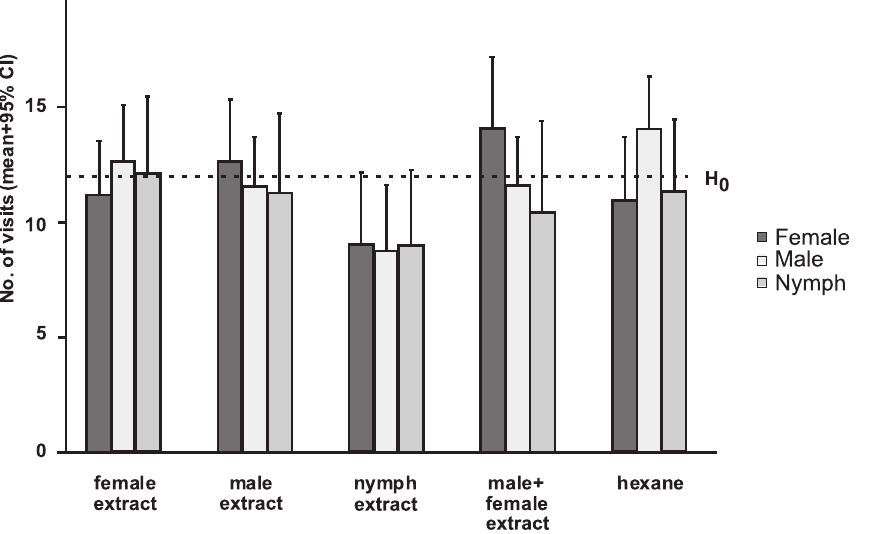
Figure 3. Behavioural responses to conspecific whole body extracts in C.hemipterus . Number of visits to the odour-containing area by either males, females or nymphs of C. hemipterus to whole body extracts of males (20), females (20), last instar nymphs (20), or a mix of males and females (10 + 10) recorded every fifth second of observation during two minutes. The dotted line represents the null hypothesis (50%).